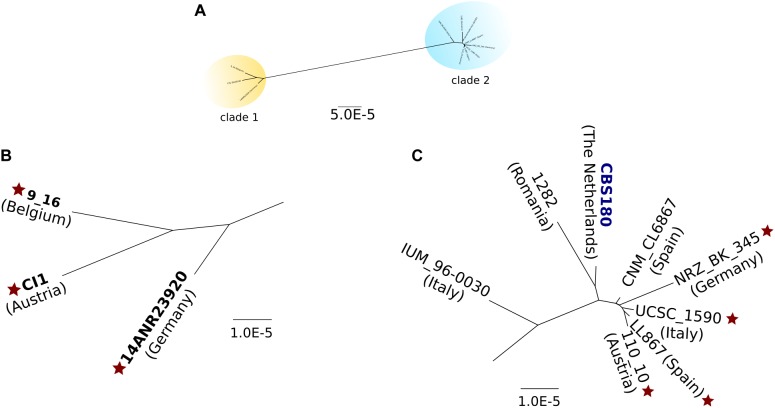
Maximum likelihood phylogeny of all C. inconspicua strains. A concatenated alignment of 9,971,439 bp was used to reconstruct this phylogeny. Positions with heterozygous variants or INDELs in at least one strain were removed from the analysis. The type strain is marked in dark blue. Diploid strains are highlighted in bold. Star indicates invasive strains. (A) Overall view of the nuclear genome phylogeny of C. inconspicua, with two distinct clades highlighted in yellow (clade 1) and blue (clade 2). (B) Closer view on C. inconspicua clade 1. (C) Closer view on C. inconspicua clade 2.